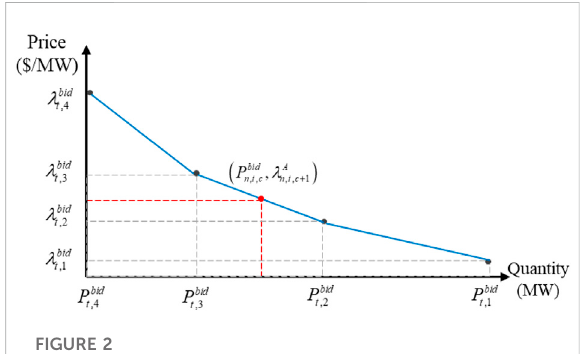
FIGURE 2 The bidding curve of the load aggregator for the day-ahead energy market. The bidding model of LA in the real-time balance